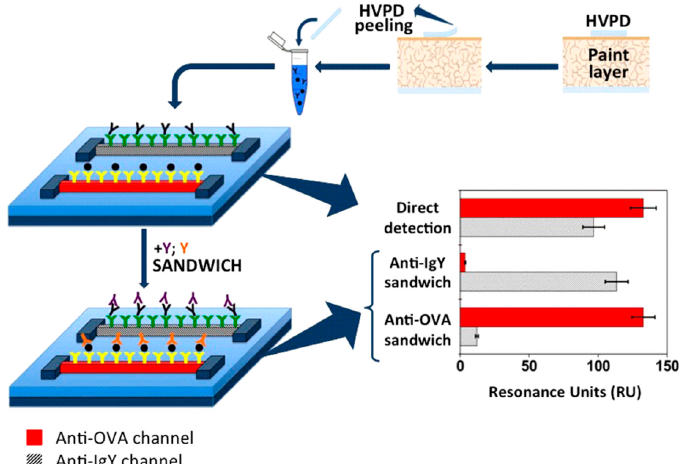
Figure 11. On the left of picture, a typical scheme of the Surface Plasmon Resonance biosensor assembly has been highlighted. On the right, a typical resonance response plot is also shown. Reproduced and reprinted with permission from [22].